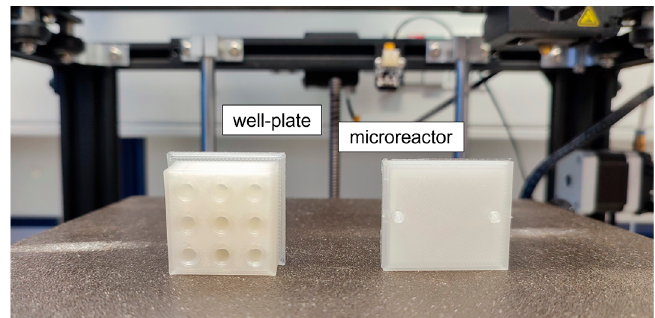
Figure 1. 3D ‐ printed models made of natural polylactic acid (PLA). The well plate can be designed with a customized number of wells depending on the experimental needs, while the microreactor bares a serpentine ‐ like internal shape in order to hold more volume in a smaller space. The models are ready ‐ to ‐ use after printing (no post ‐ printing treatment needed).